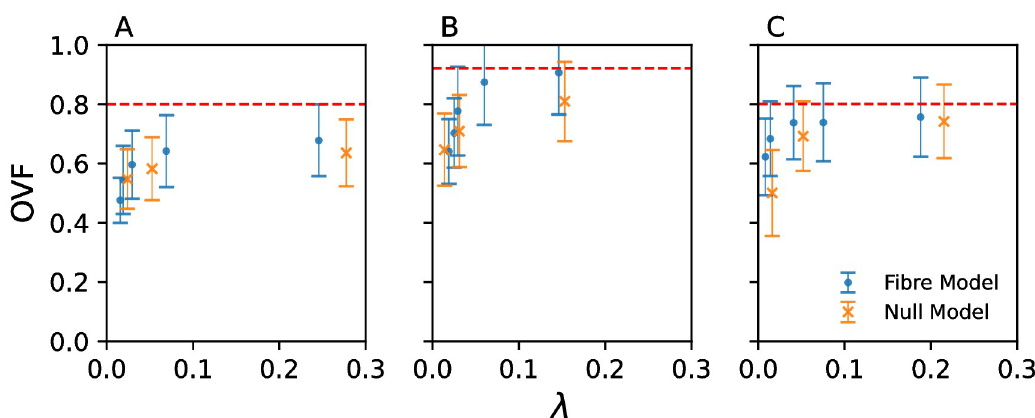
Fig 8. The occupied voxel fraction averaged over voxels where micro-reentry is detected. Data for the fibre model (blue points) and the fibre-less null model (orange crosses) for (A) the human atria, (B) the healthy sheep atria, and (C) the HF sheep atria, as a function of the global risk parameter, λ . The dashed line in each subfigure is the average value of the occupied voxel fraction for all the voxels in the atrial geometry.